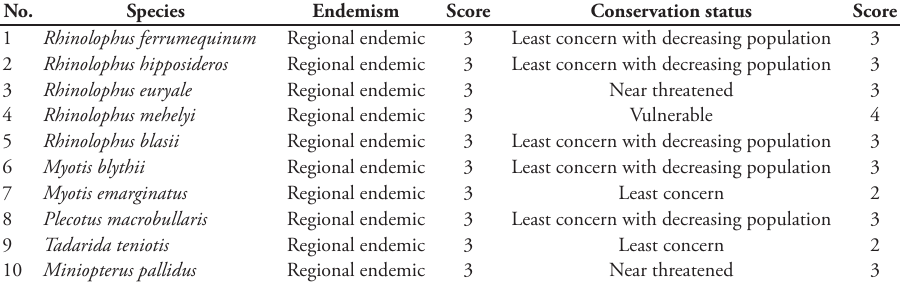
Table 4. Endemism and conservation status and scores for each species observed in Kurdistan caves. Score number follows the methodology in Tanalgo et al. 2018.